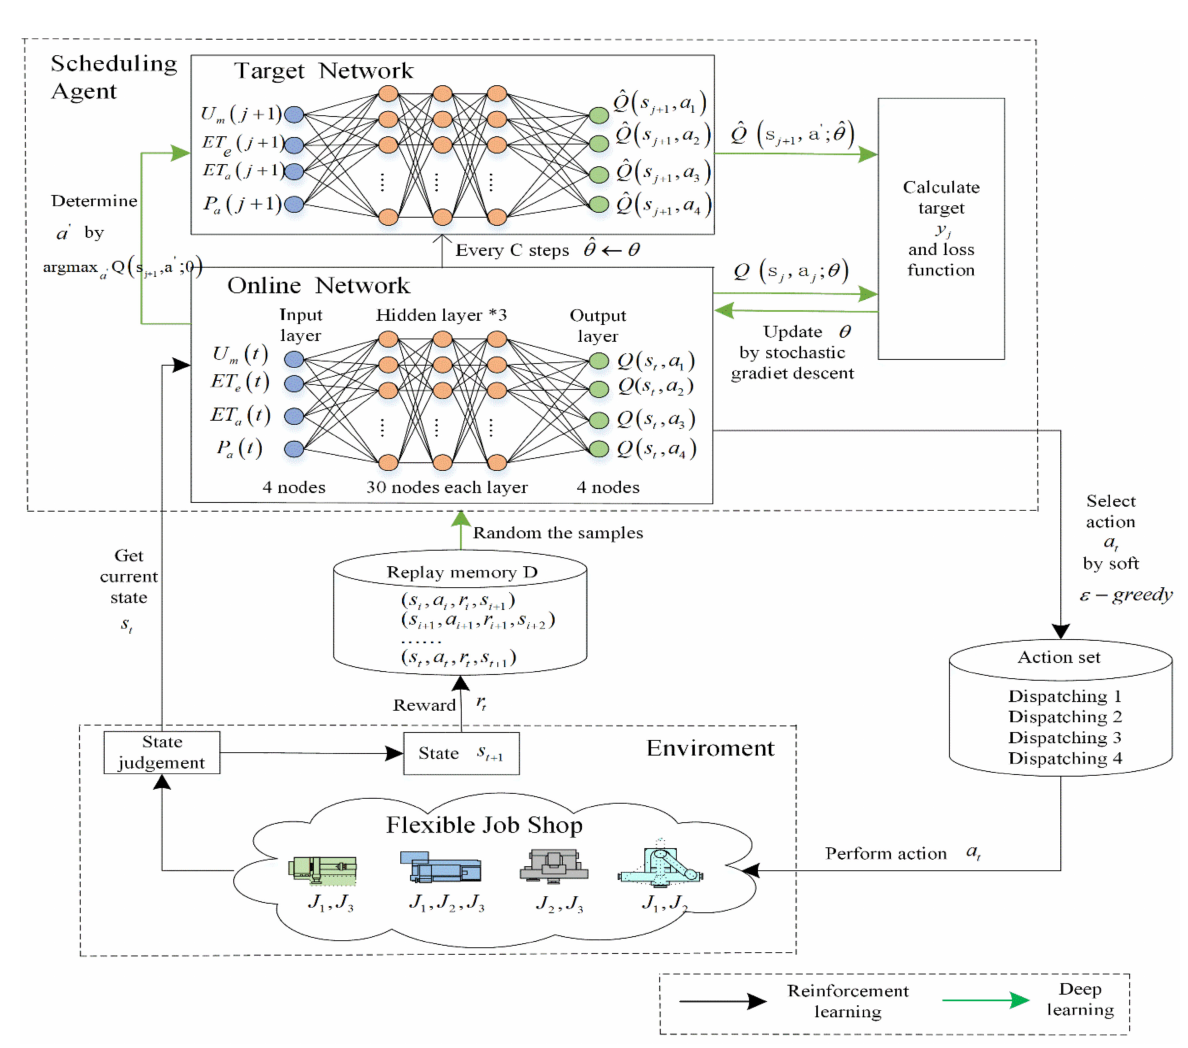
Figure 1. The model architecture of solving the DFJSP using the